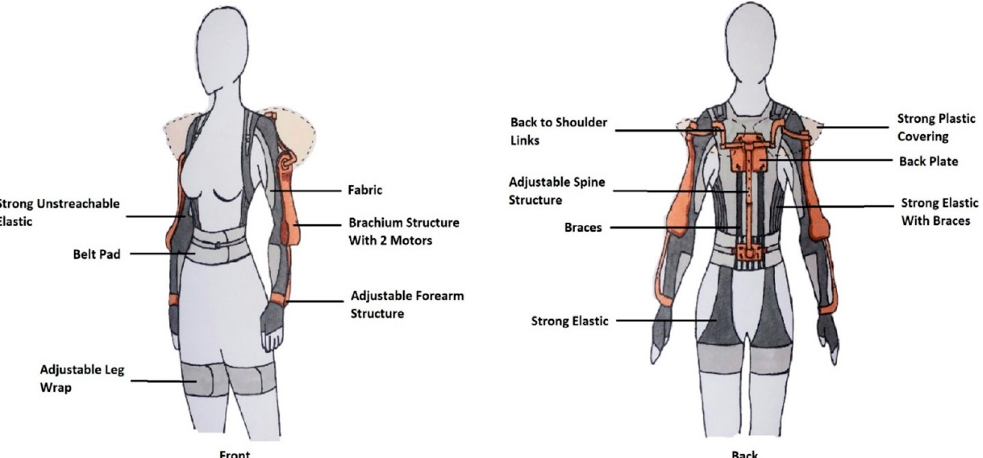
Figure 6. Sketch of the Conceptual Exoskeleton.